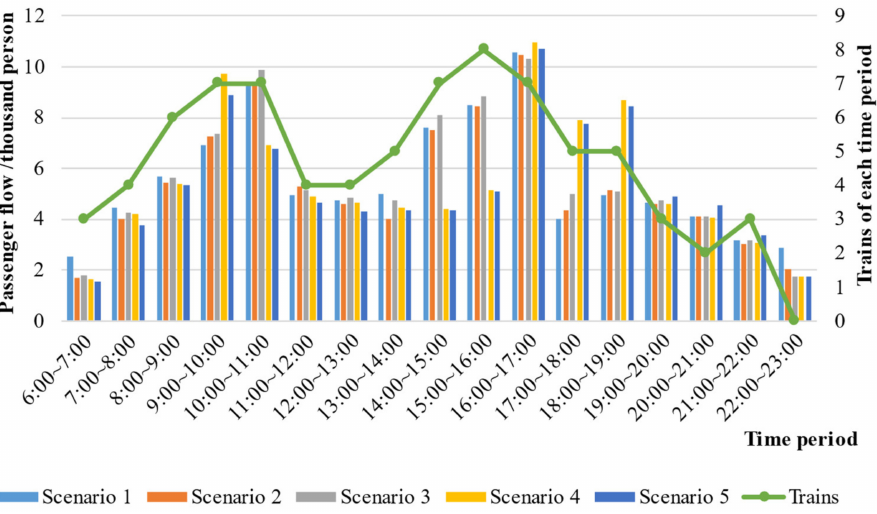
Figure 10. Matching between the number of trains and OD passenger flow during each time